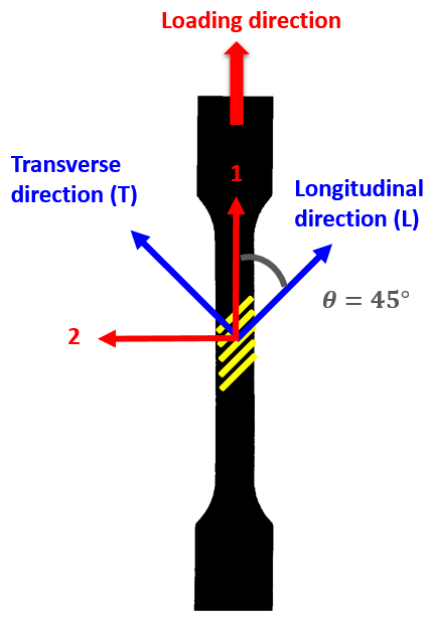
Figure 6. Local and global references definition for the 45° specimen .